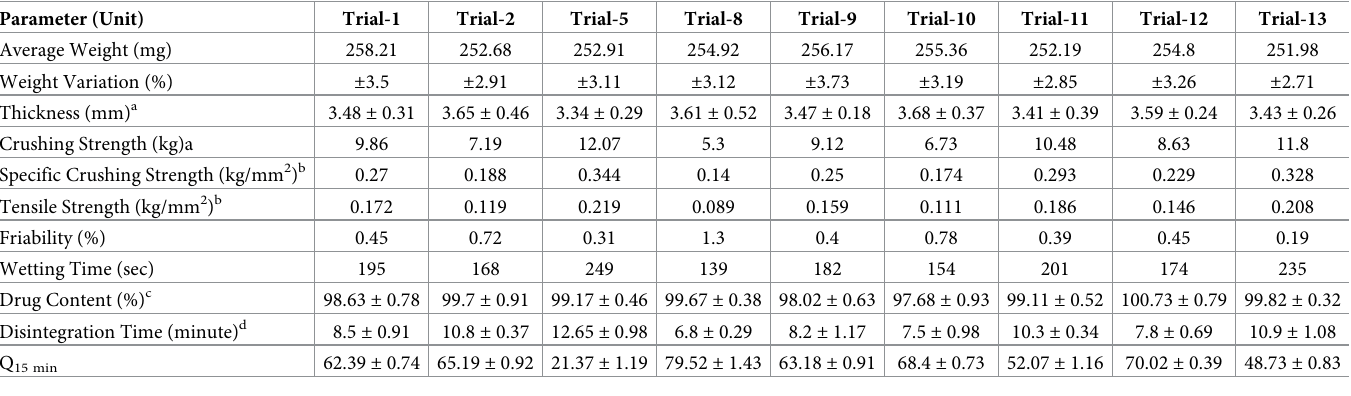
Table 8. Post compression evaluation of atenolol tablets prepared by high shear granulation under different process